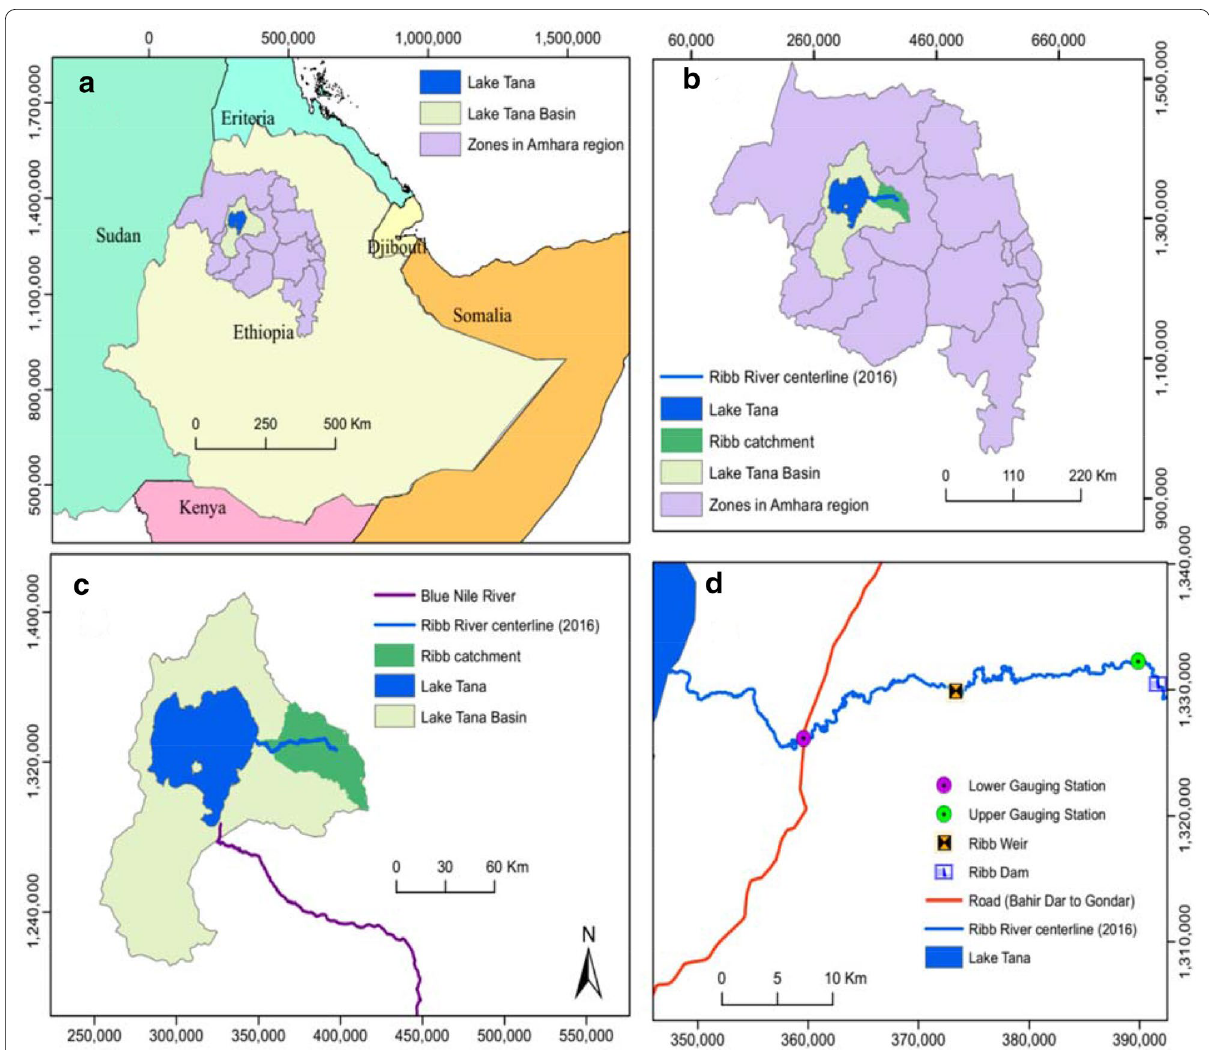
Fig. 1 Location map of the study area. a Ethiopia; b Amhara region divided in Administrative Zones; c Lake Tana basin highlighting Lake Tana, Blue Nile River and Ribb River catchment; d studied river reach including Ribb dam, Ribb weir, Upper and Lower gauging stations, and the 2016 river centerline (Woldemariam